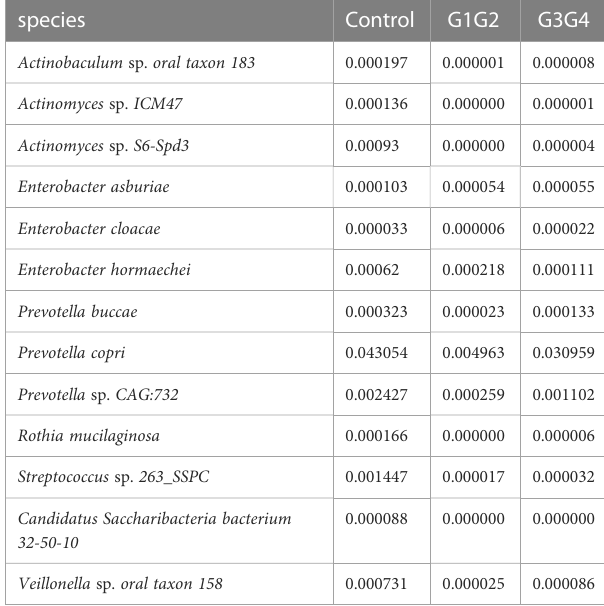
TABLE 8 Relative abundance of differential strains enriched in the G3G4